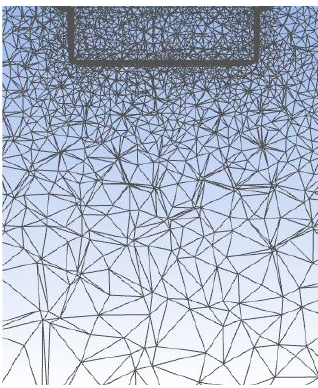
Figure 14. Mesh distributions inside and below the tank in cross section.